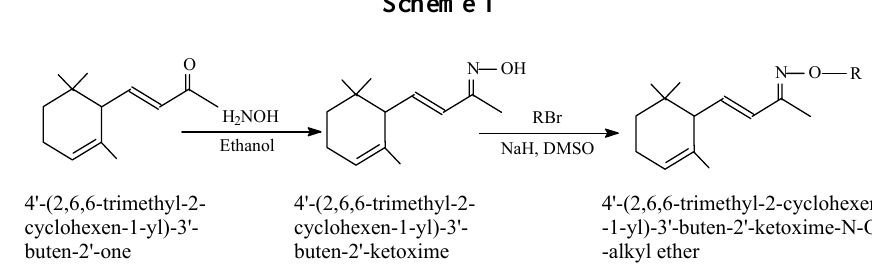
1:1 mixture of E and Z isomers inseparable by conventional chromatographic techniques. The 4’- (2,6,6-trimethyl-2-cyclohexen-1-yl)-3'-buten-2'-ketoxime was then reacted with an appropriate alkyl halide (Scheme I) to furnish the oxime ethers, which were separated into their geometric isomers by column